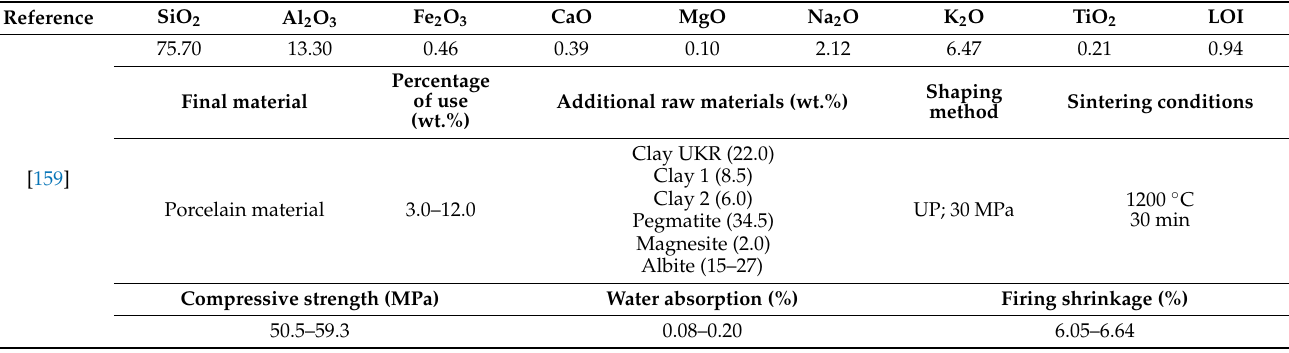
Table 28. Chemical composition (expressed wt.% oxide), processing parameters and technological properties of ceramic materials developed from rhyolite waste.